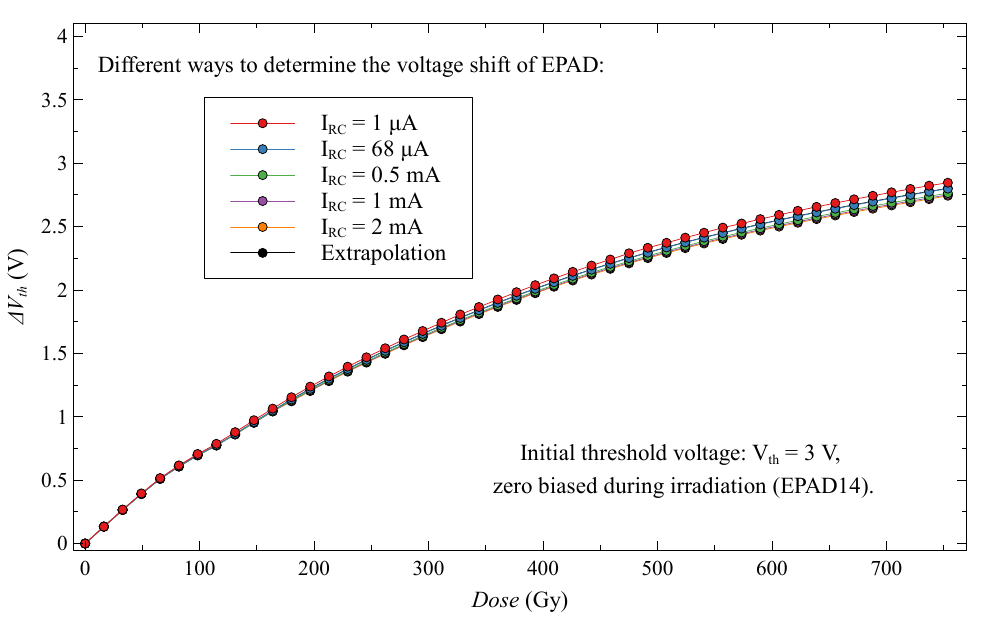
Figure A1. Good example of different Reader-Circuit values.